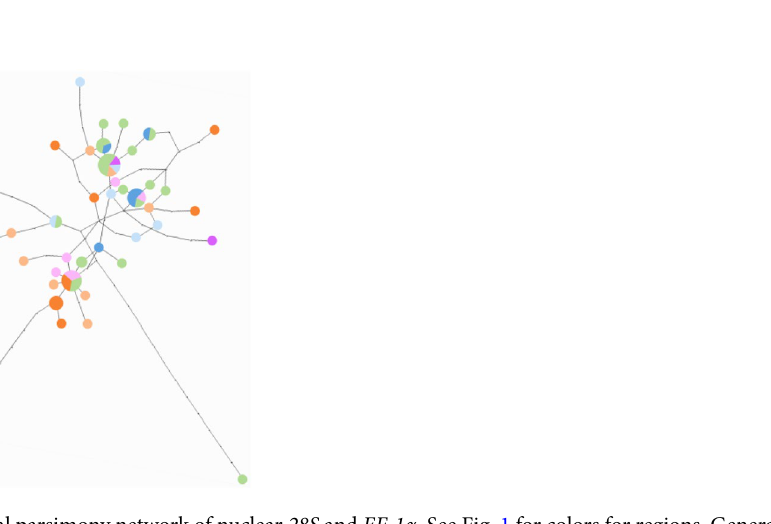
Figure 3. Statistical parsimony network of nuclear 28S and EF-1α. See Fig. 1 for colors for regions. Generated using TCS 1.21 80